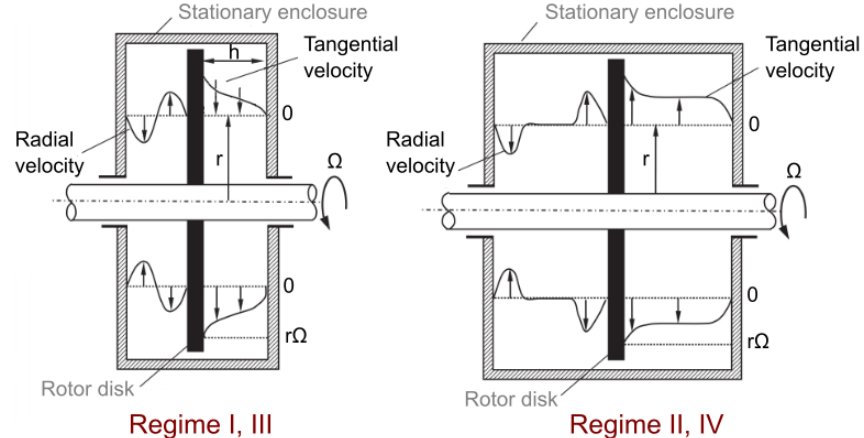
Figure 5. Velocity profiles and boundary layers for different regimes. Reproduced with permission from [18], Cambridge University Press, 2018.